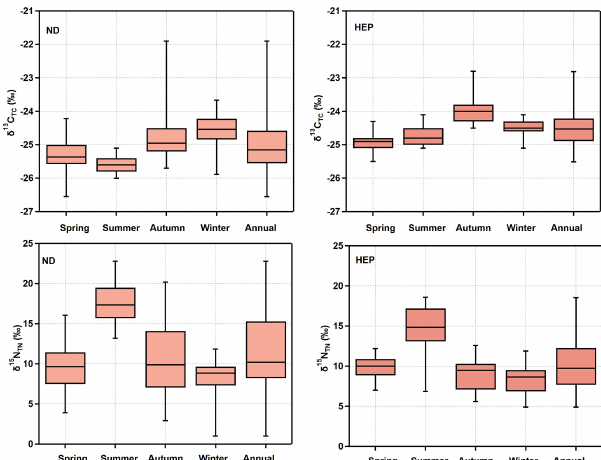
Figure 7. Box-and-whisker plot of seasonal variations in stable car- bon and nitrogen isotope ratios of total carbon ( δ 13 C TC ) and nitro- gen ( δ 15 N TN ) in PM 2 . 5 at ND and HEP in Tianjin during the cam- paign. The cross bar in the box shows the median, and the open circles show the